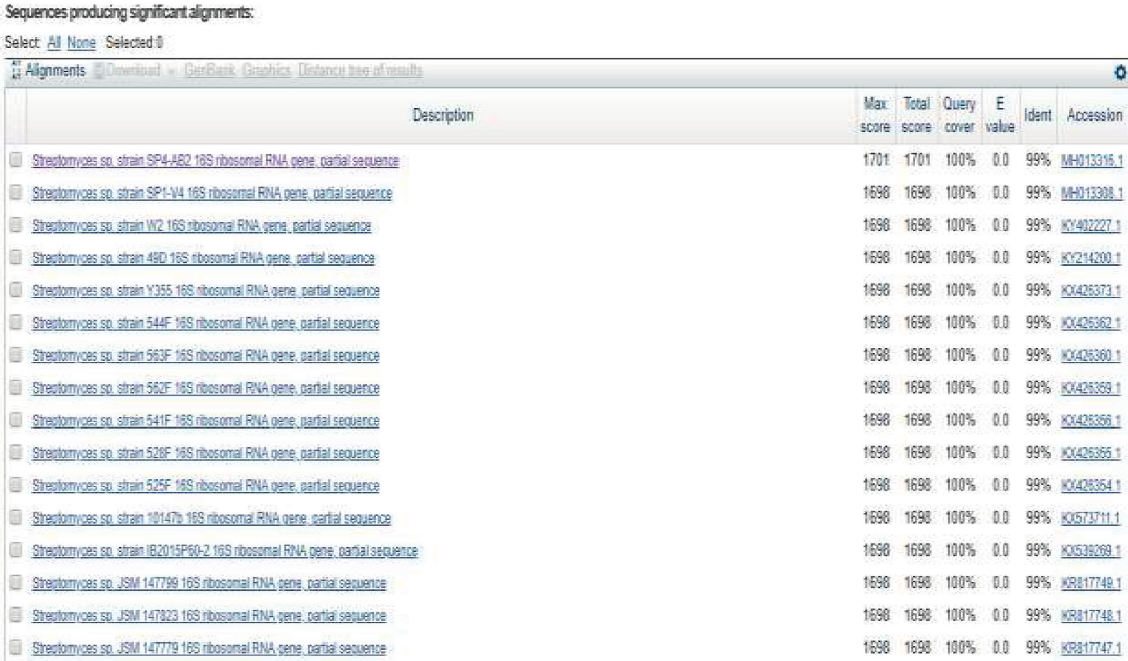
Figure 11: NCBI-BLAST result for KGT32 16S rRNA gene